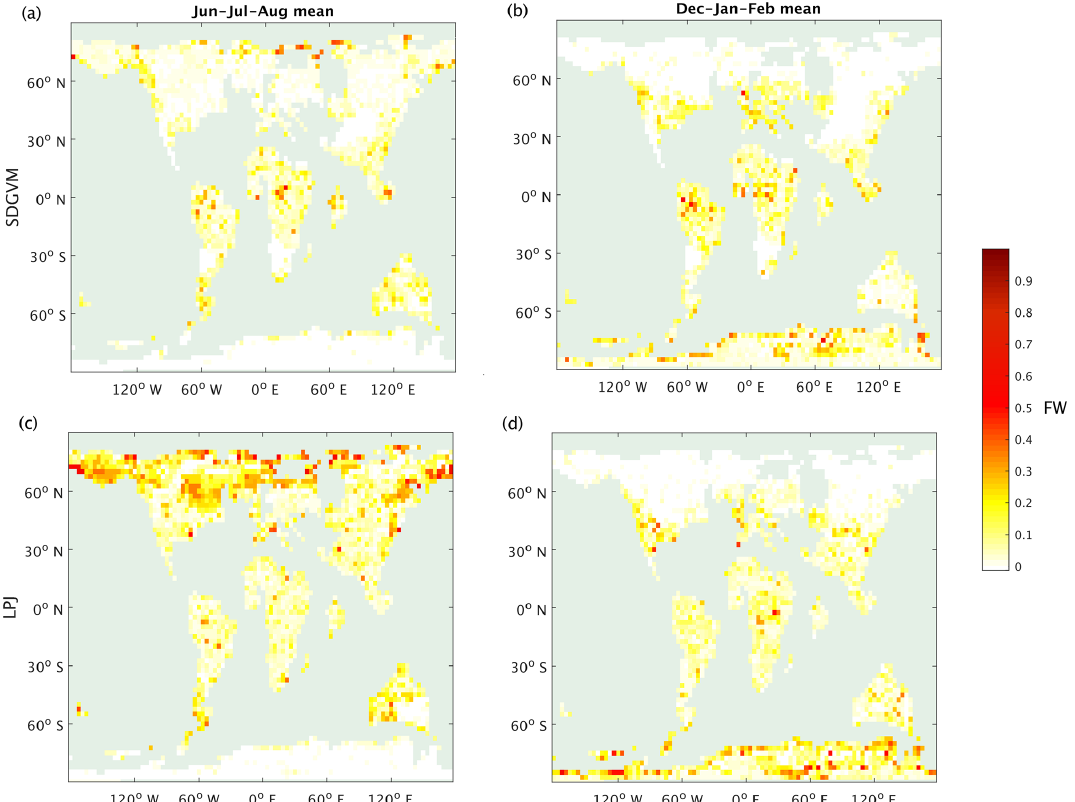
Figure 10. Seasonal mean FW predicted for the Eocene climate by SDGVM and LPJ using the max3NN (a) SDGVM June–July–August,